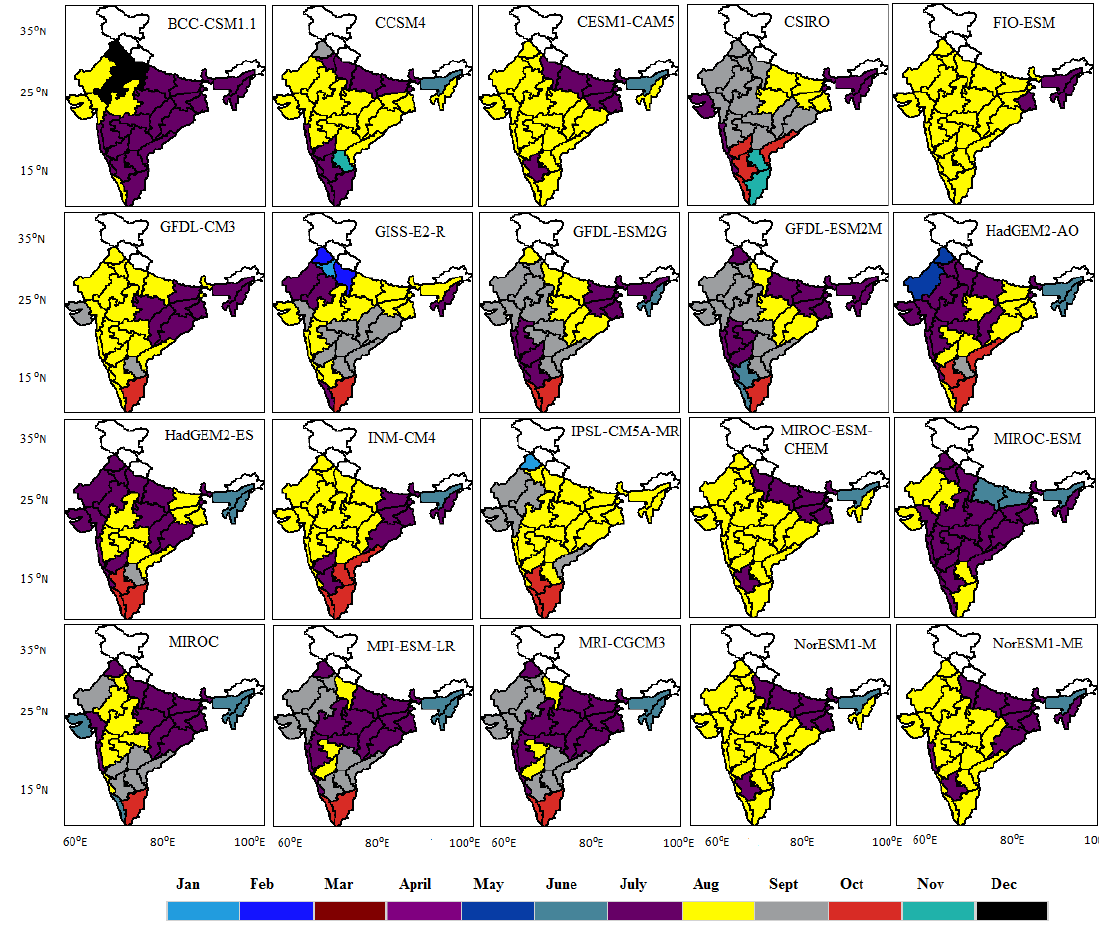
Figure 5. Projected MRPM of Indian meteorological sub-division of the 20 models.